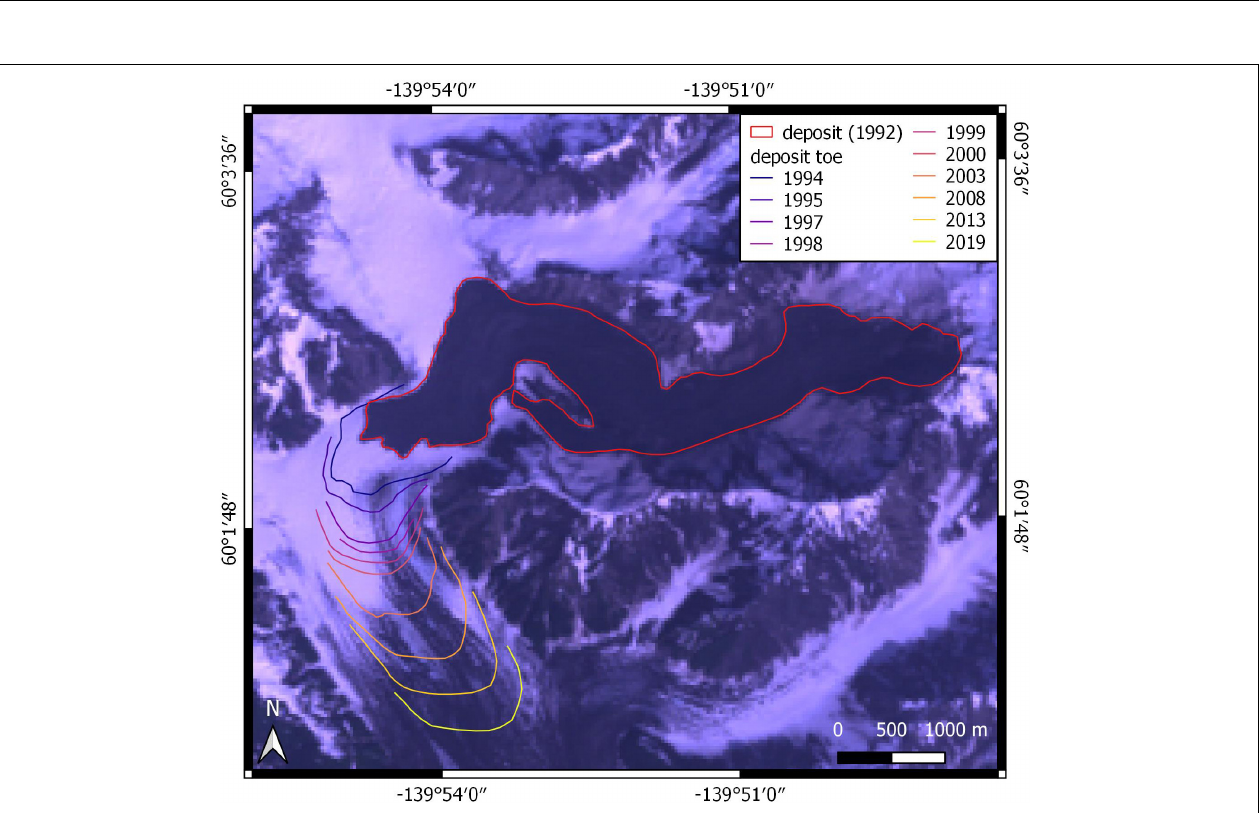
FIGURE 7 | Landsat image acquired on 10 August 1992 showing RA 33, which occurred between 25 July 1992 and 2 August 1992. In subsequent years, the rock avalanche toe was visible on the surface of Lucia Glacier, as shown by colored lines.